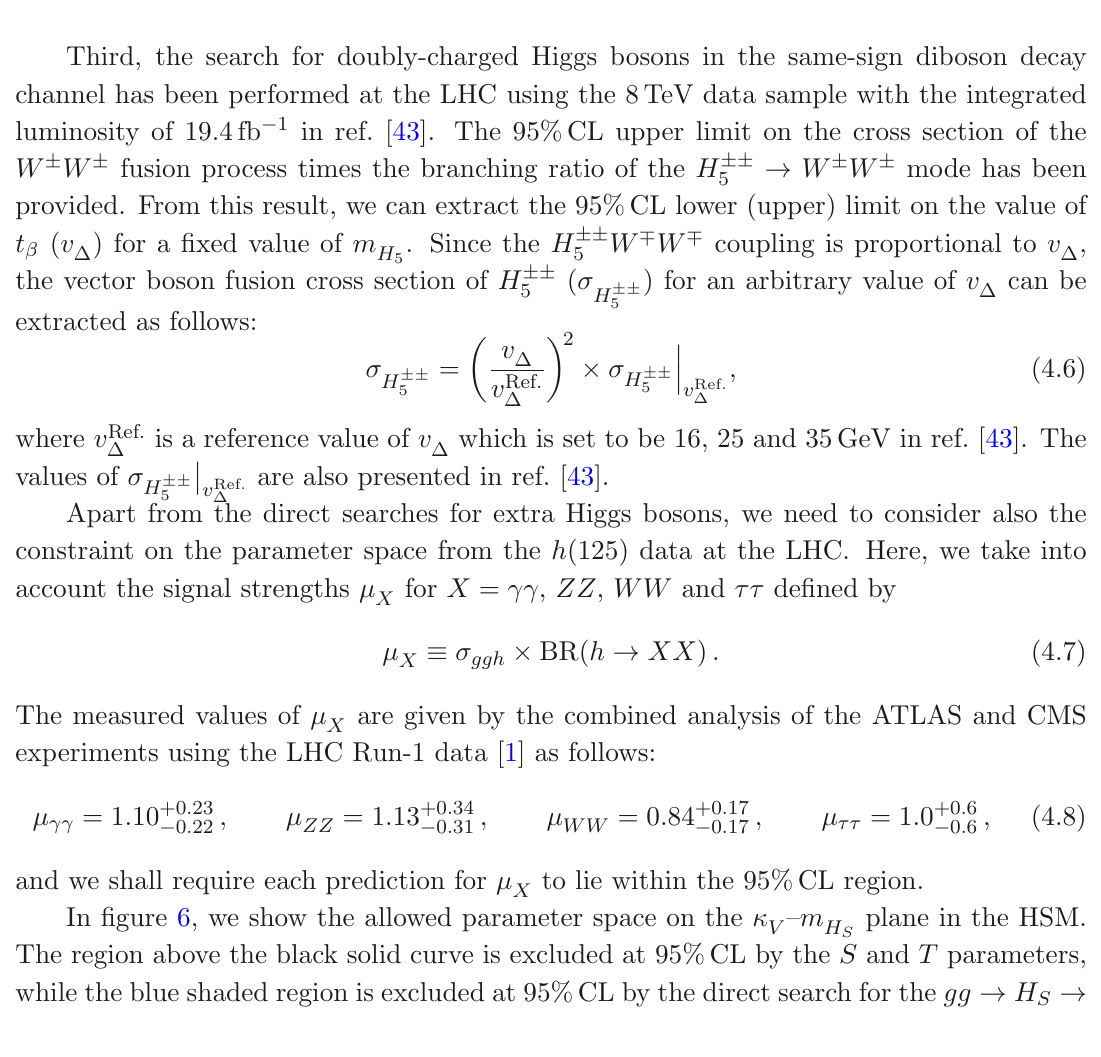
Figure 6 . Allowed parameter space on the κ excluded by the search for the gg excluded by the S and T parameters. In this plot, we take λ Φ S = µ S = λ S =